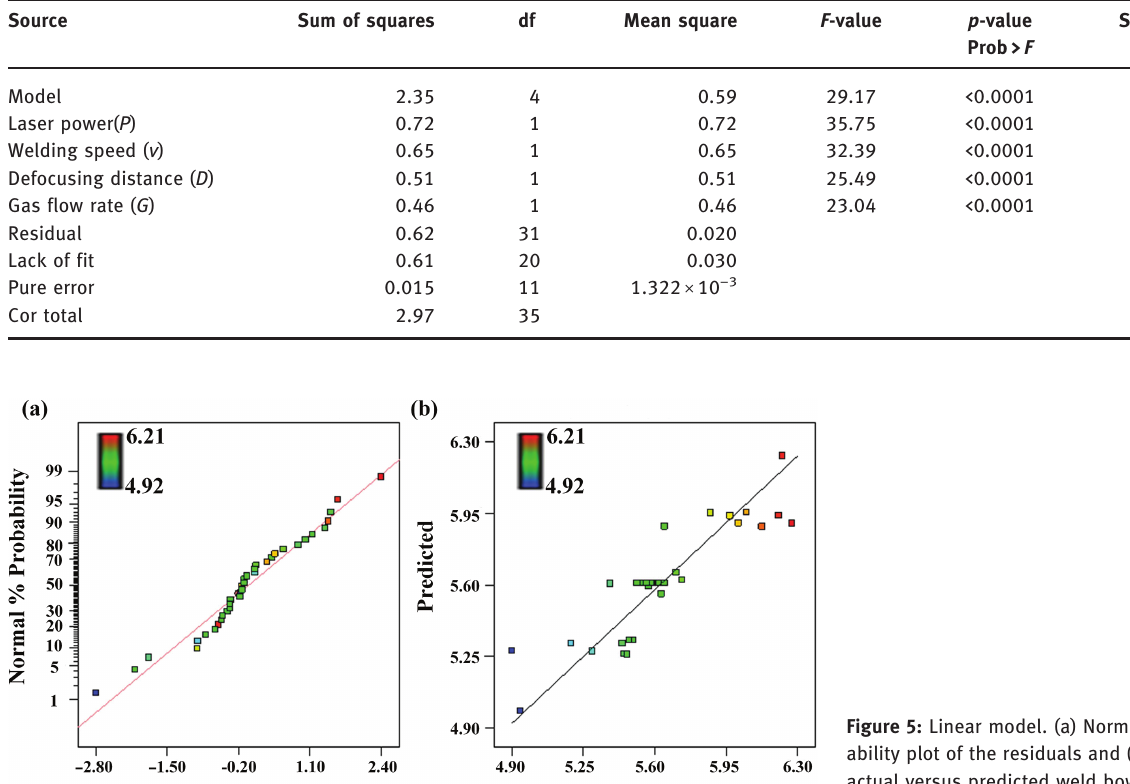
Table 7: Variance analysis of the linear model.